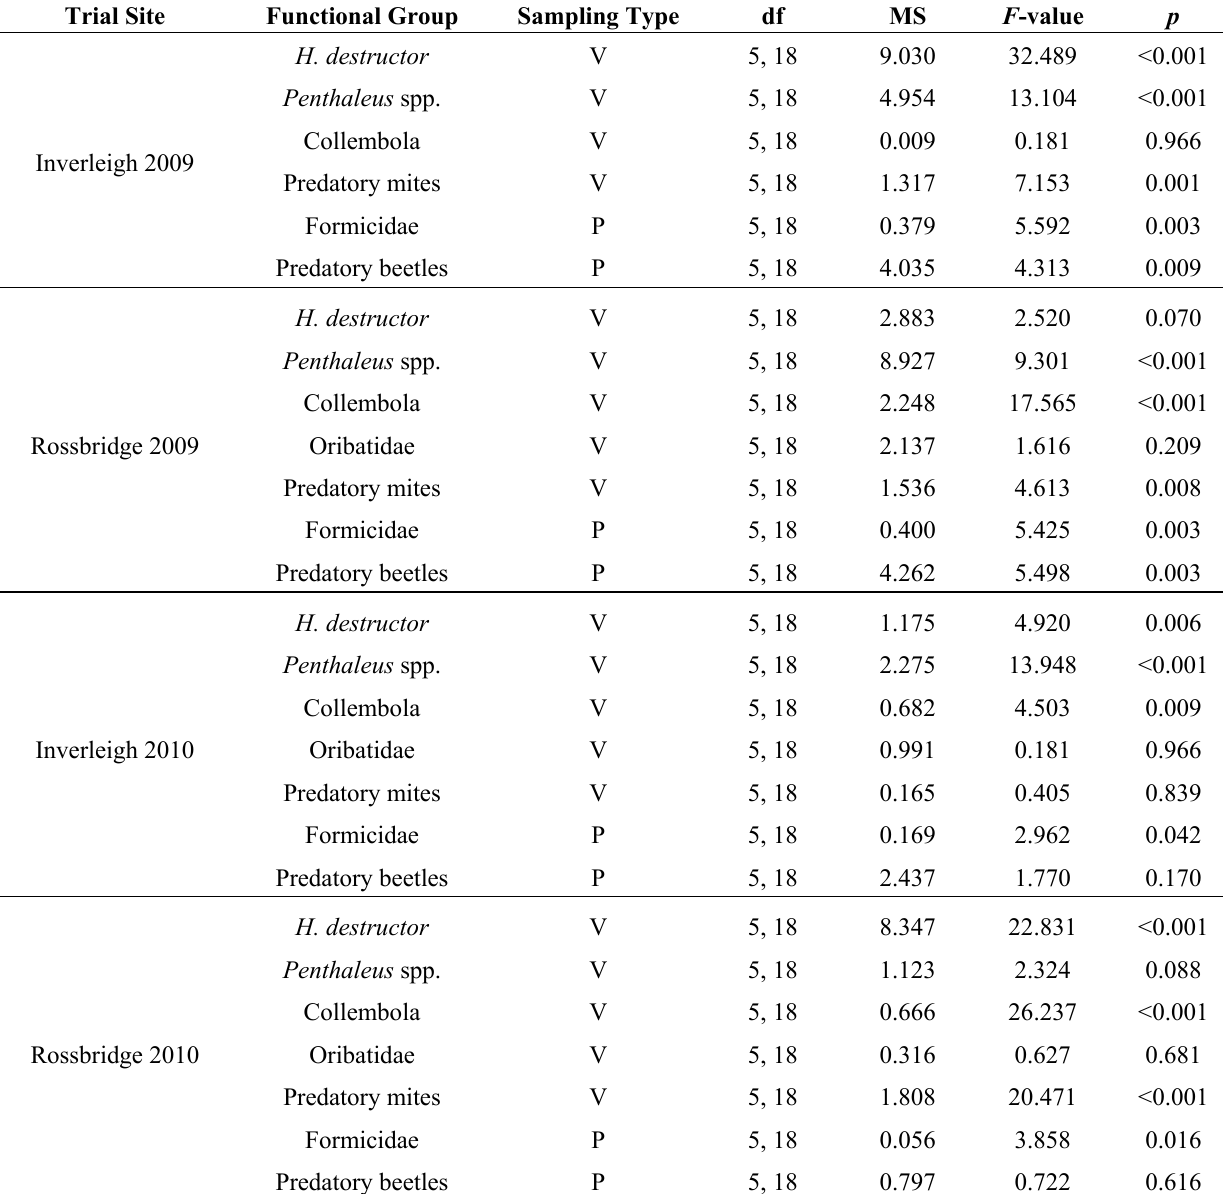
Table 2. Repeated measures ANOVAs comparing the overall treatment effects on pest species and non-target invertebrate numbers collected from vacuum (V) and pitfall (P) samples across each field